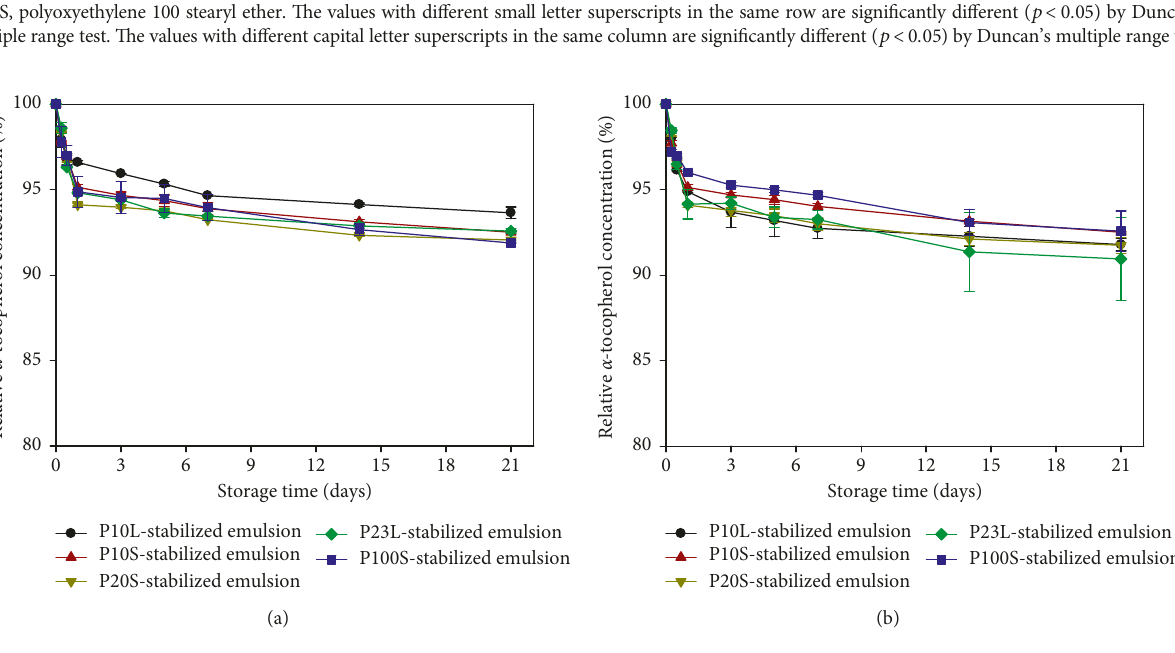
Figure 3: Change in concentration of α -tocopherol in emulsions in the presence of ferrous iron at pH 7 (a) and 3 (b) stored at 25 ° C. P10L, polyoxyethylene 10 lauryl ether; P10S, polyoxyethylene 10 stearyl ether; P20S, polyoxyethylene 20 stearyl ether; P23L, polyoxyethylene 23 lauryl ether; P100S, polyoxyethylene 100 stearyl ether.